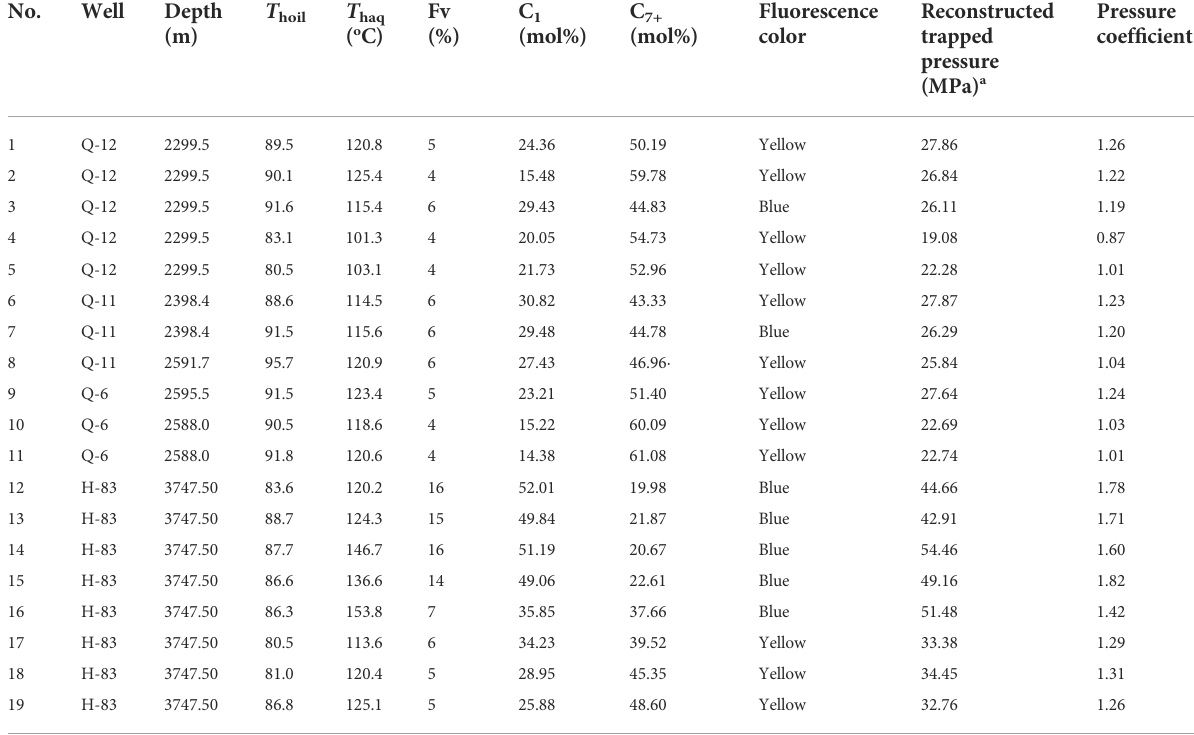
TABLE 6 Petroleum inclusion trapped pressure analysis